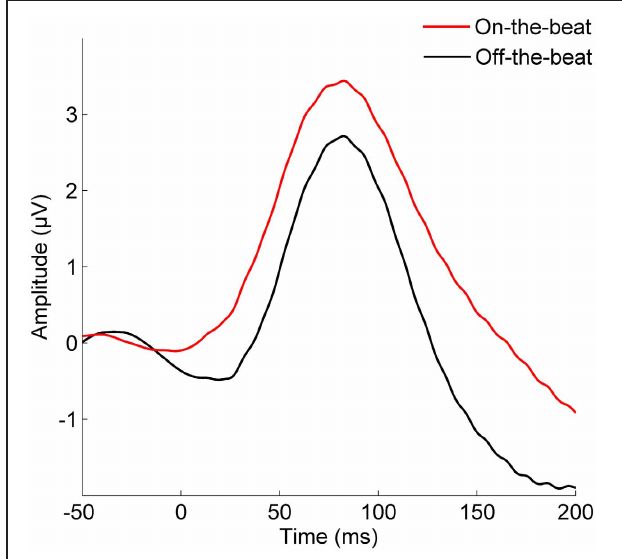
FIGURE 1 | The effect of musical rhythm on cortical sound processing. The cortical P1 onset response is enhanced when a target sound is aligned with the beat of the music, rather than shifted away from the beat (paired t -test, t = 4 . 79, p < 0 .